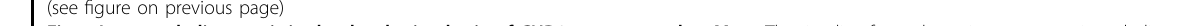
Fig. 4 Increased gliogenesis in the developing brain of CHD8 mutant monkey M1. a The timeline for embryonic neurogenesis and gliogenesis in the macaque monkey. b The coronal section of the control-1 monkey (E130) showing the cortex, caudate, corpus callosum and LV. Rectangle indicates the location of brain slices that were used to examine the staining and numbers of neuronal and glial cells. Scale bar: 1 mm. c The brain slice used for examination consists of different lays including the inner subventricular zone (iSVZ), outer subventricular zone (oSVZ), intermediate zone (IZ), and subplate (SP). d Immunostaining of progenitor cells with antibodies to EGFR and Pax6. The nucleus was stained with hematoxylin. Scale bar: 100 μ m. e Immunostaining of the white matter near the LV with antibodies to olig2 and GFAP, respectively. Scale bar: 100 μ m. f Quanti fi cation of the relative numbers of EGFR- and Pax6-positive cells in iSVZ and the numbers of oligodendrocytes and astrocytes in the brain slices. The data were obtained by counting 4 – 7 brain slices per group and presented as means ± SEM. ** P < 0.01; *** P <